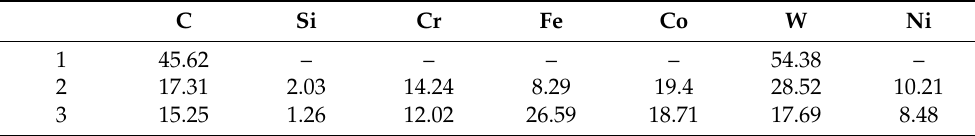
Figure 3. SEM images of ( a – d ) the cross-section of the Fe-5 coating, ( e – h ) SEM images of the cross- section of the Fe-20 coating and ( i – l ) EDS images of the middle zone in the Fe-20 coating. Table 4. Chemical composition (at %) of the points in the fusion